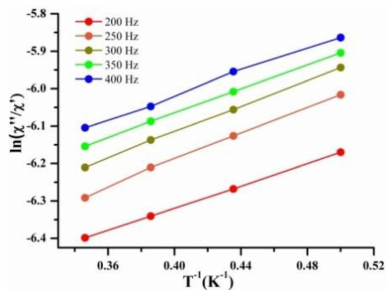
Figure 6. The solid lines represent fit to the Debye model according to Equation